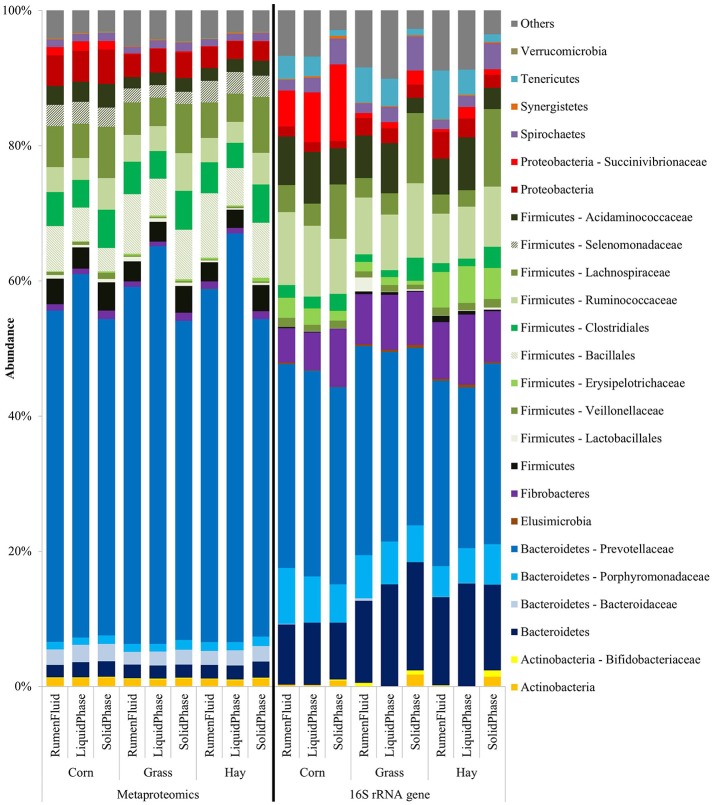
Bacterial phylogenetic distribution in diets and sample fractions (n = 3) obtained from the metaproteome (8,163 proteins) on the left and the 16S rRNA gene sequencing (1,484 OTUs) on the right. The order of Bacillales and the family of Selenomonadaceae were found exclusively in the metaproteomic dataset (shaded coloring).